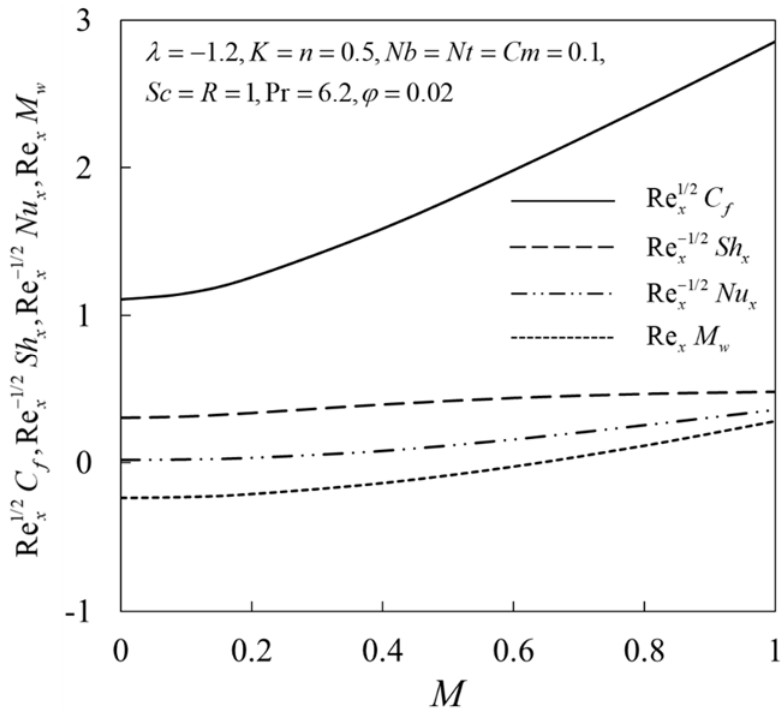
Figure 3. Re (cid:3051)(cid:2869)/(cid:2870) 𝐶 (cid:3033) , Re (cid:3051)(cid:2879)(cid:2869)/(cid:2870) 𝑆ℎ (cid:3051) , Re (cid:3051)(cid:2879)(cid:2869)/(cid:2870) 𝑁𝑢 (cid:3051) , and Re (cid:3051) 𝑀 (cid:3050) vs. 𝑀 . Figure 3. Re 1/2 x C f , Re − 1/2 x Sh x , Re − 1/2 x Nu x , and Re x M w vs. M